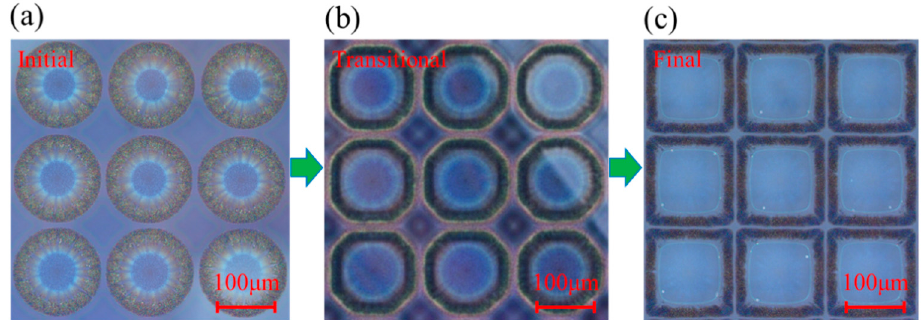
Figure 2. The dynamic formation process of obtained microstructure (left to right): ( a ) the initial state, ( b ) the transitional state, and ( c ) the final state.